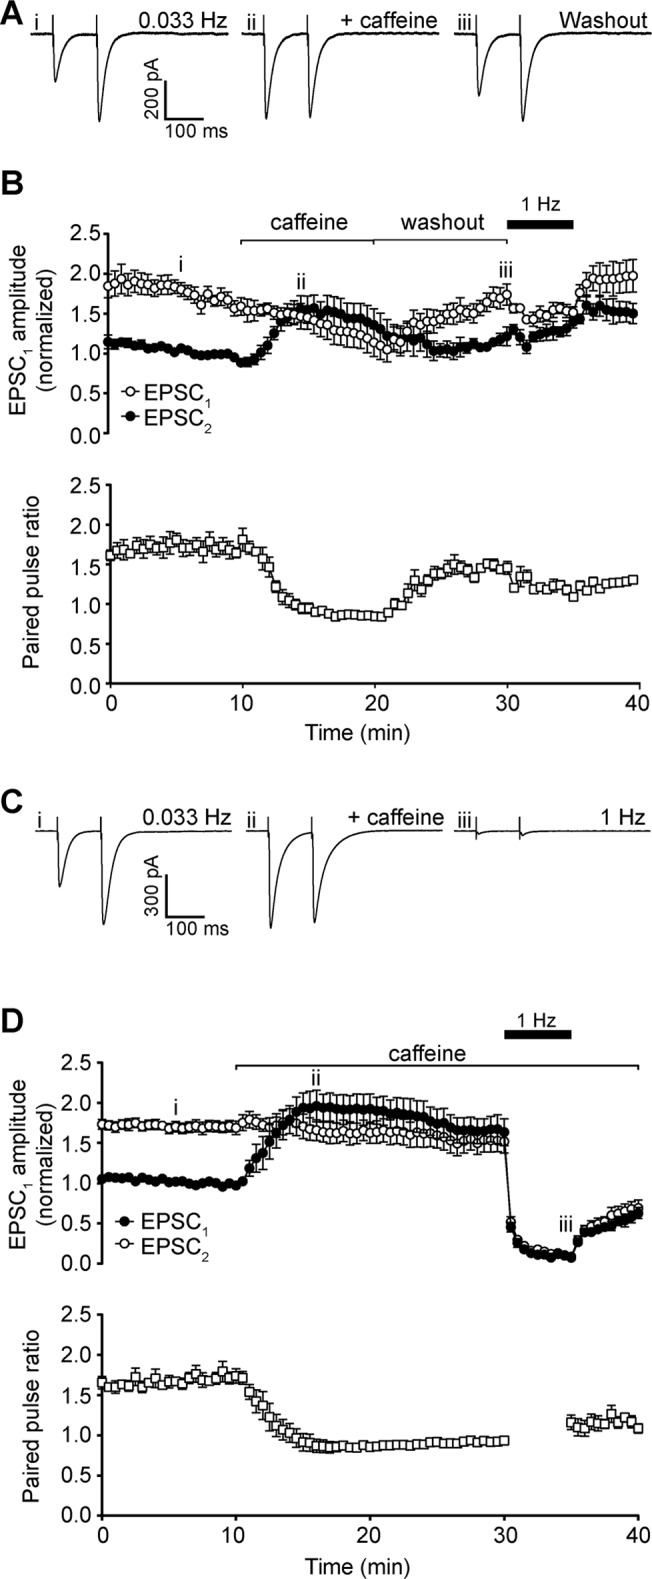
Effects of washout and osmolarity on caffeine-mediated effects.A) Representative recordings of Purkinje neuron EPSC at under control conditions (first panel), peak effect following the addition of 50 mM caffeine (second panel), and following 10 mins of wash-out (third panel). Roman numerals refer to time points in 10B. B) Time course of effect of washing out caffeine on amplitude (upper panel) of the first (filled circles, EPSC1) and second (open circles, EPSC2) pulse in each pair, and on and paired-pulse ratio (lower panel). Data are mean ± s.e.m. from 6 cells (4 animals). C) Representative recordings of Purkinje neuron EPSC at under control conditions (first panel), after addition of 50 mM caffeine in isosmotic Krebs buffer (second panel), and following 5 mins of 1 Hz stimulation (third panel). Roman numerals refer to time points in 10D. D) Time course of caffeine effect on amplitude (upper panel) of the first (filled circles, EPSC1) and second (open circles, EPSC2) pulse in each pair and on paired-pulse ratio (lower panel) after addition of isosmotic caffeine solution to bath. Data are mean ± s.e.m. from 6 cells (3 animals).